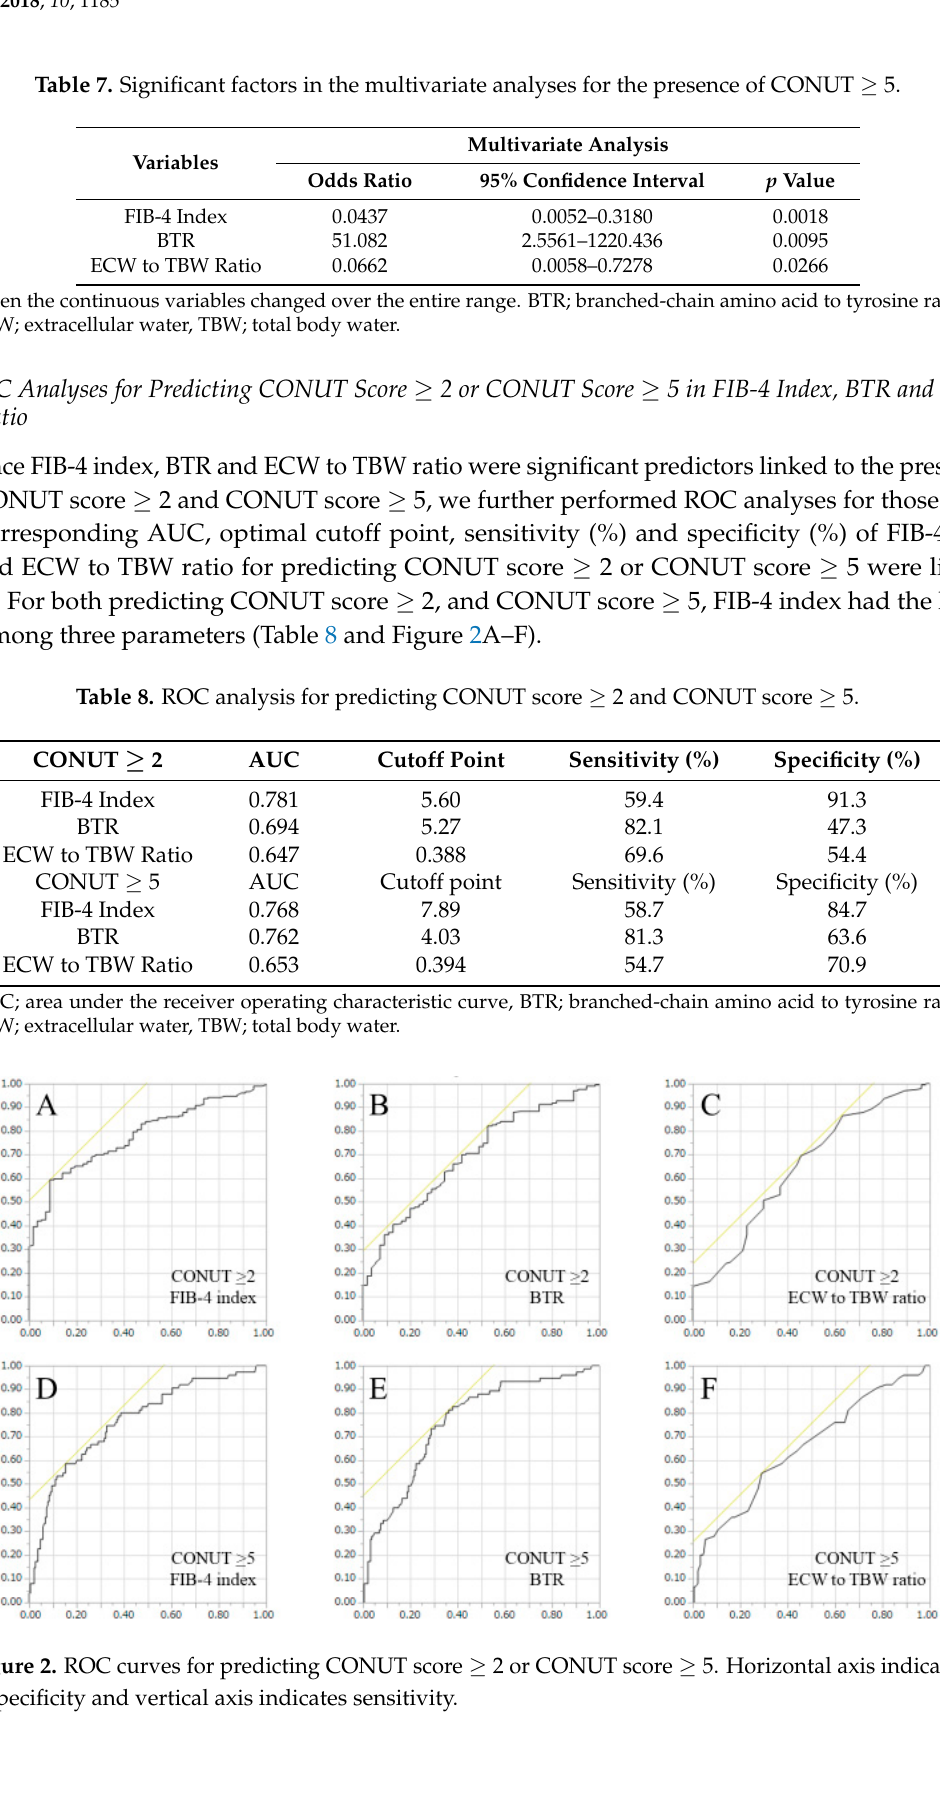
Table 7. Significant factors in the multivariate analyses for the presence of CONUT ≥ 5.